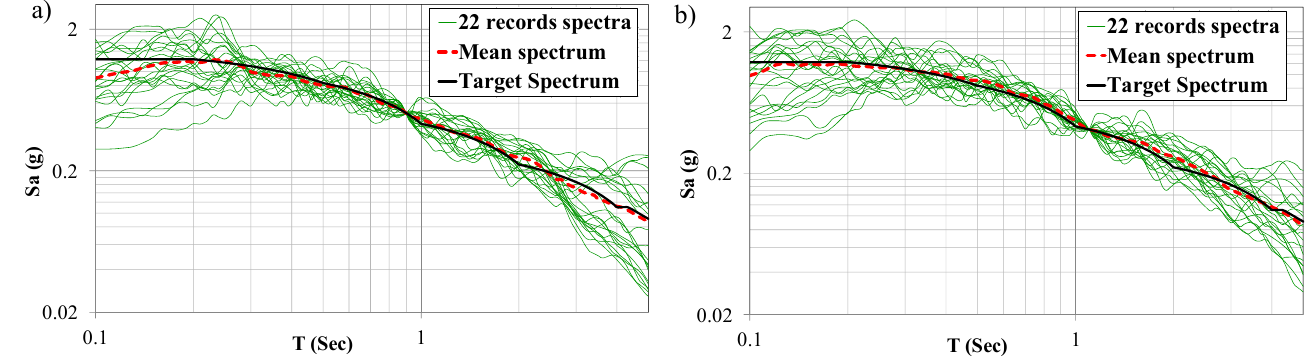
Figure 5. SRSS response spectra and mean SRSS spectrum of 22 records used for the analysis of: ( a ) regular bridge; ( b ) irregular bridge